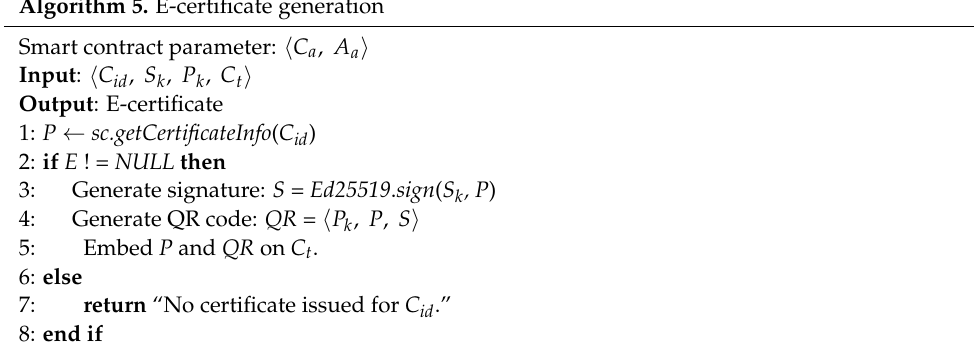
Algorithm 5. E-certificate generation